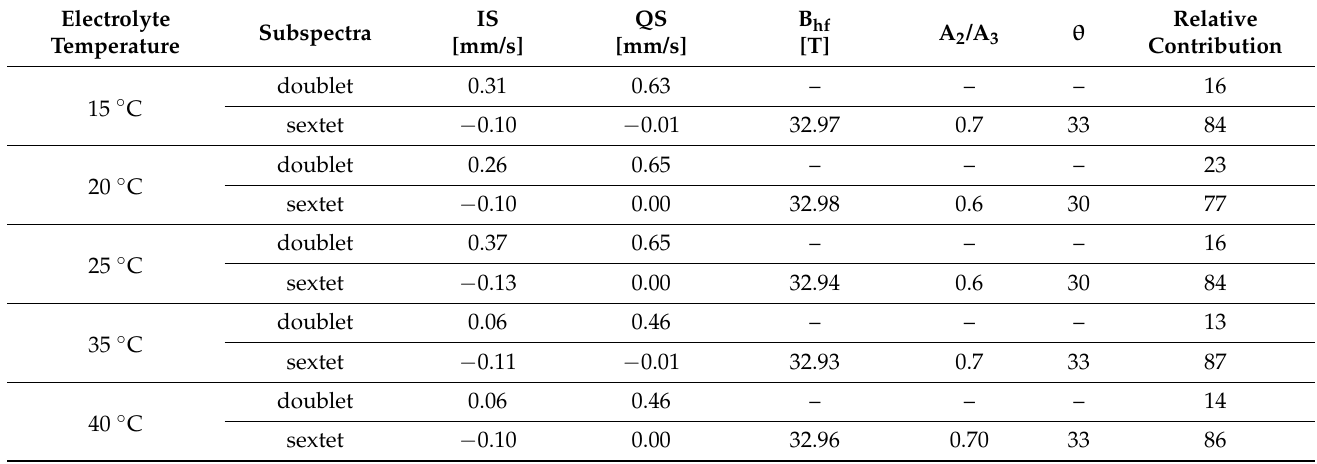
Table 1. The hyperfine parameters of the spectra that were measured for the nanowires deposited at different electrolyte